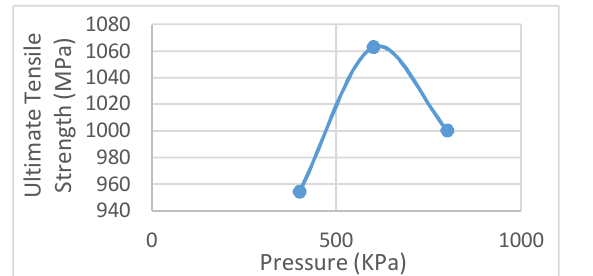
Fig 13: Effect of pressure on the UTS for steel and 1400 rpm respectively. The only variable was the applied pressure. As shown, the maximum ultimate tensile strength was achieved at a pressure of 600KPa. For Aluminum, with a diameter of 10mm and spindle speed of 1400 rpm, the maximum UTS was for the weld at a pressure of 200kpa as shown in Fig. 14.